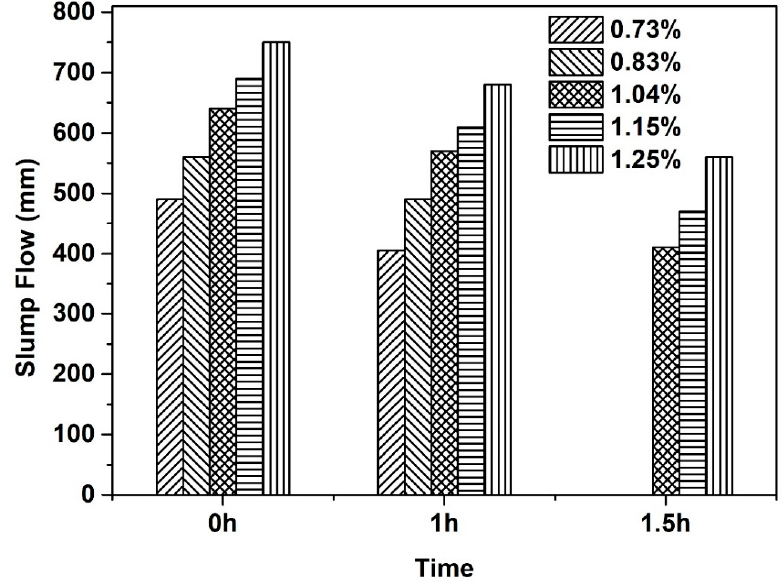
Figure 6. Influence of superplasticizer dosage on slump flow of fresh concrete mixtures at different time after mixing.